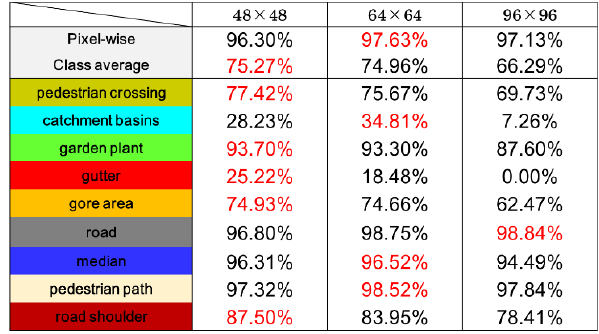
Table 1. Accuracy of our method. Left: 48 ×48 pixels, middle: 64 ×64 pixels, Right: 96 ×96 pixels